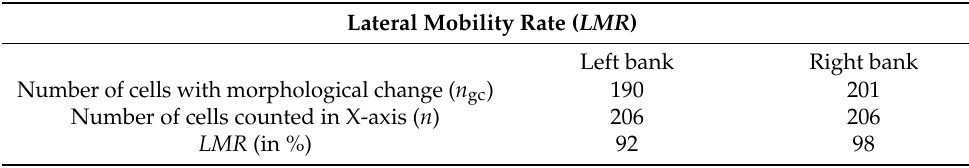
Table 3. Application of the LMR indicator from the study case (Clamoux River). Lateral Mobility Rate ( LMR ) Left bank Right bank Number of cells with morphological change ( n gc ) 190 201 Number of cells counted in X-axis ( n ) 206 206 LMR (in %) 92